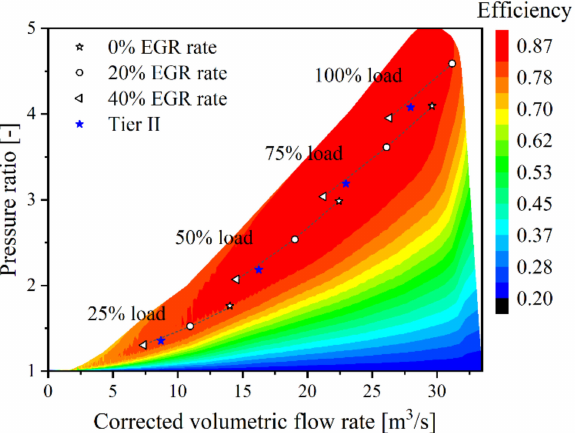
Figure 11. Effects of EGR rate on TC-L compressor operating points of the AL-EGR engine